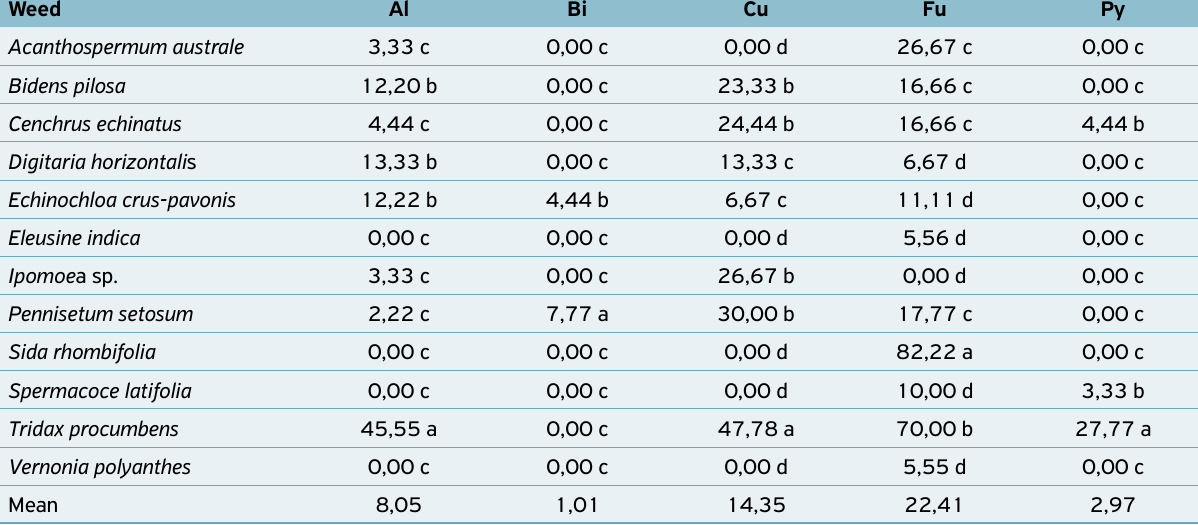
Al: Alternaria sp.; Bi: Bipolaris sp.; Cu: Curvularia sp.; Fu: Fusarium sp.; Py: Pythium sp. Means followed by the same letter in the column do not differ from each other by the Scott-Knott test at the 5% error probability